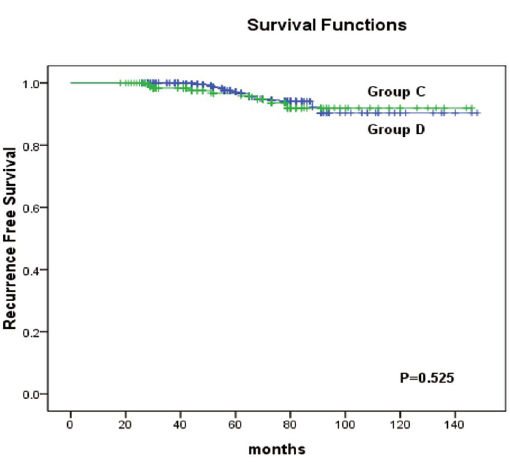
Figure 2. Kaplan-Meier analysis of recurrence-free survival of unifocal papillary thyroid cancer with a diameter of ≤ 1 cm (group C) and multifocal papillary thyroid microcarcinoma with a total tumour diameter (TTD) of ≤ 1 cm (group